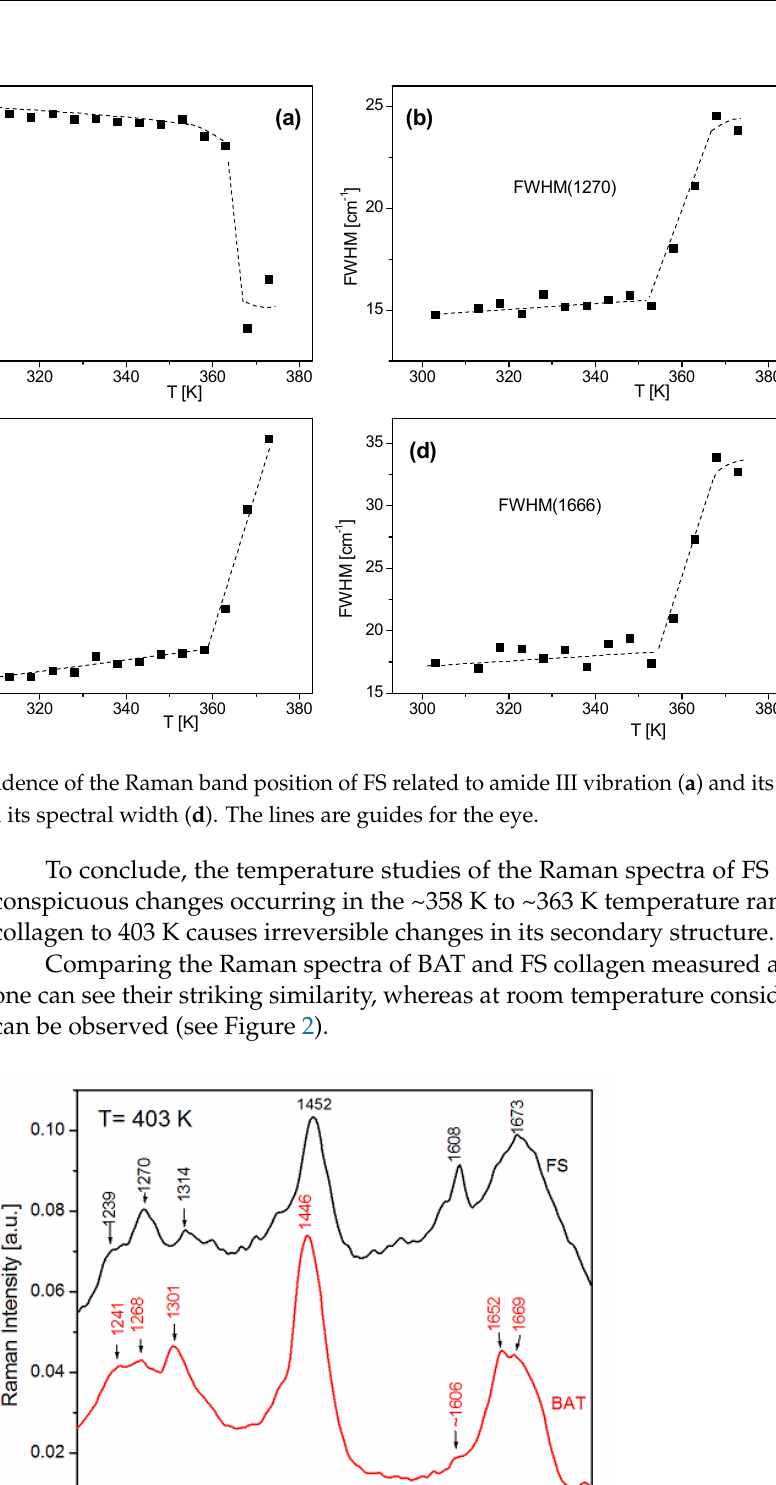
Figure 6. Comparison of Raman spectra of FS and BAT collagen in the range of amide I and amide III vibrations measured at 403 K.